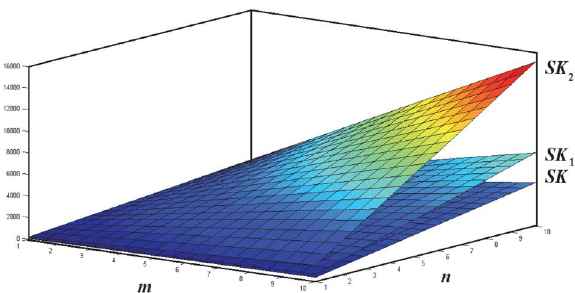
Figure 4. A comparison of SK , SK 1 and SK 2 indices of the titania TiO 2 [ m, n ] nanotubes; where m, n ∈ {1, 10}